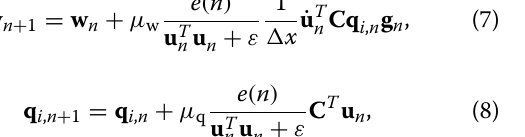
algorithm based on IIR-SAF (IIR-SAF-NLMS) can be formulated